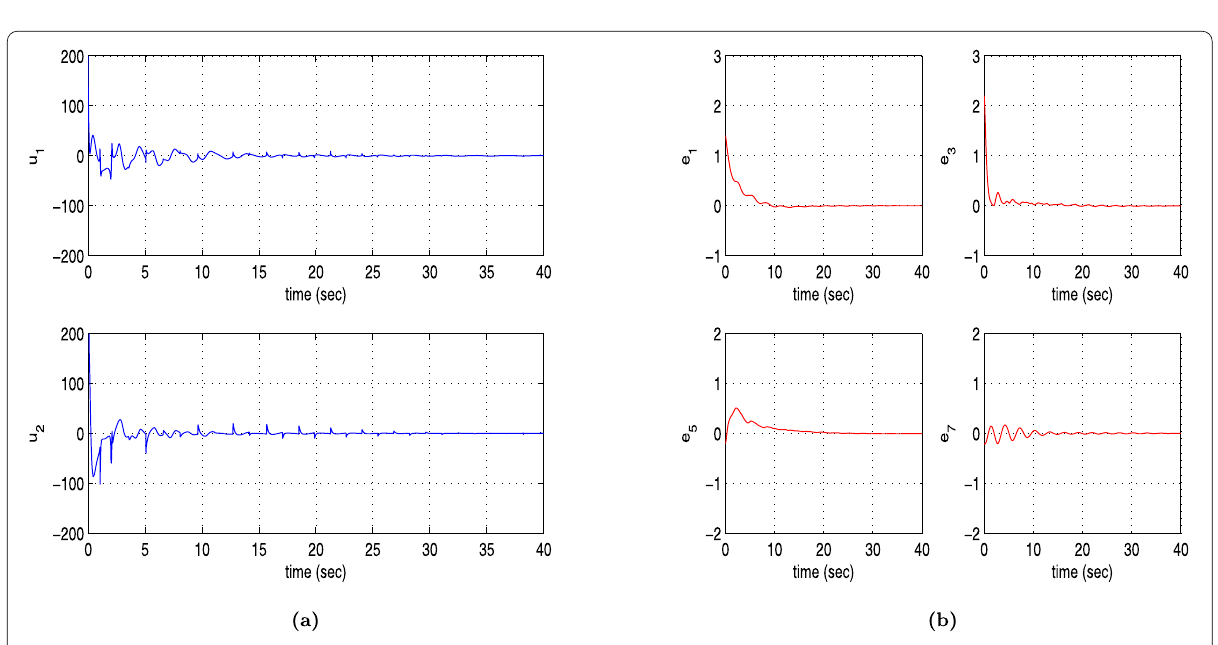
ticle’s control approach is substantially different [16].